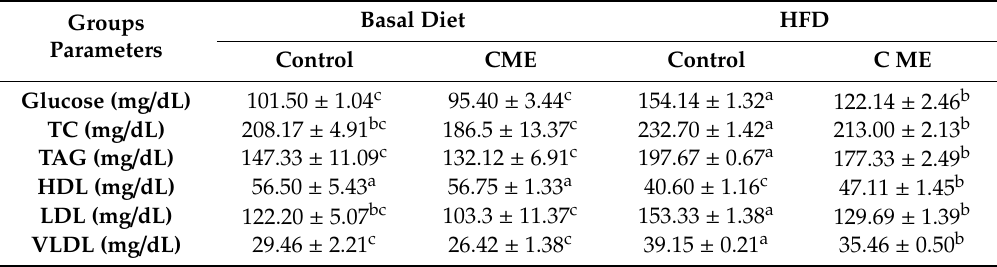
Table 4. E ff ects of HFD and / or Commiphora myrrha resin extract on blood glucose level and serum lipid profile of rats after 8 weeks.